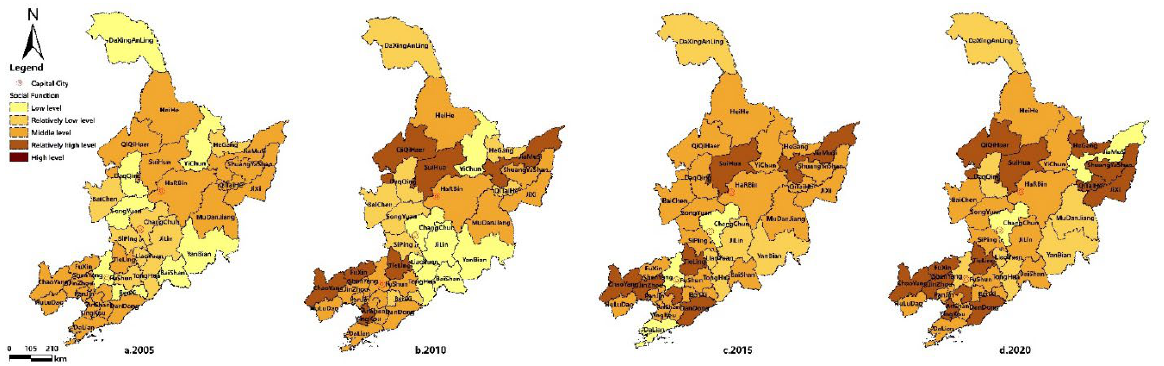
Figure 3. Spatial-temporal distribution of the social function of cultivated land in 2005, 2010, 2015, and 2020.